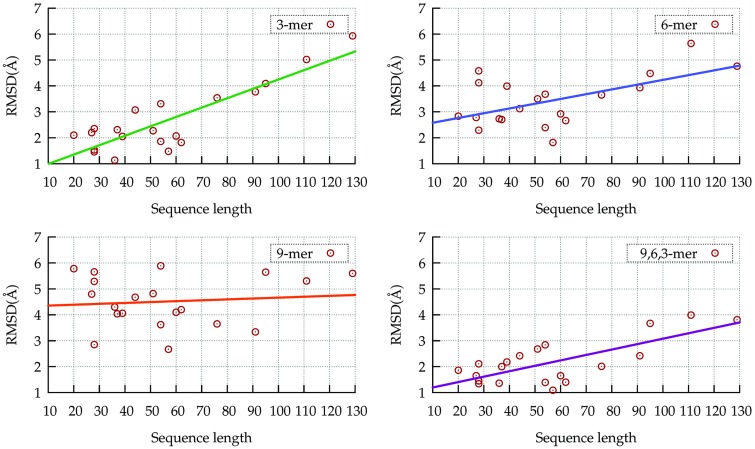
RMSDs of the best models.Comparison of the RMSD of the best models built only from 3-mers (upper left), only 6-mers (upper right), only 9-mers (bottom left) and 9,6,3-mers (bottom right).